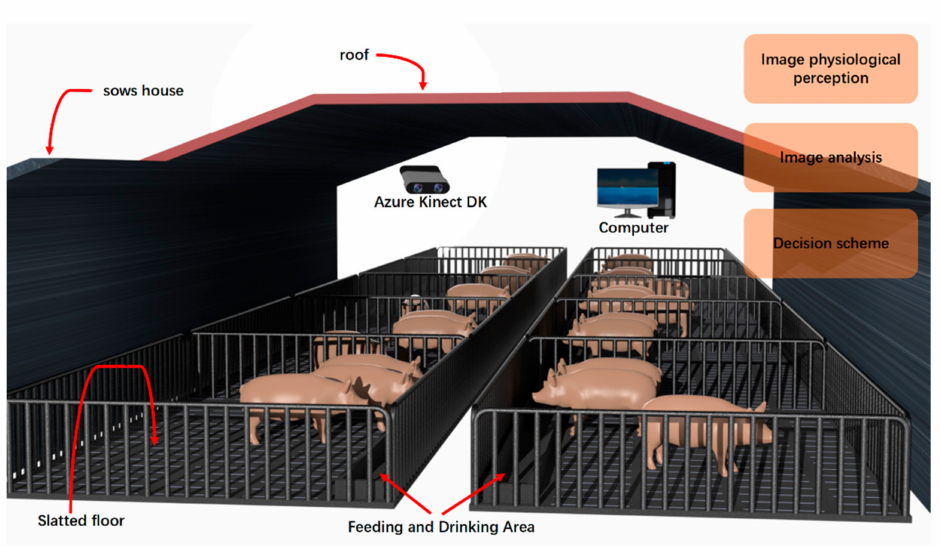
Figure 18. PLF (Precision Livestock Farming) of sow information perception